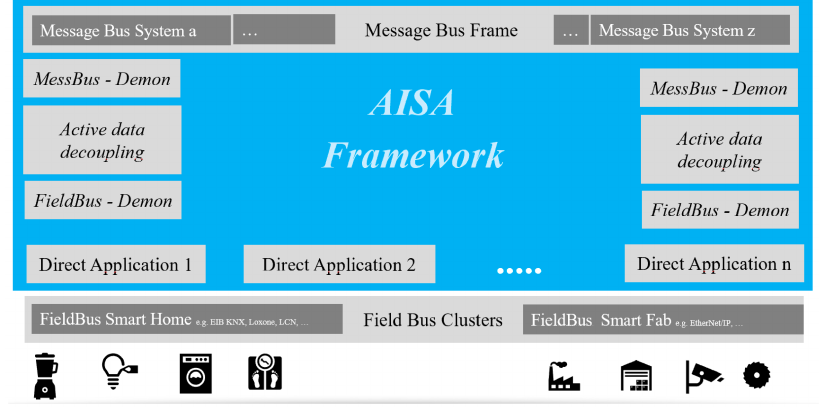
Figure 21. Overview of the AISA communication architecture (own elaboration).